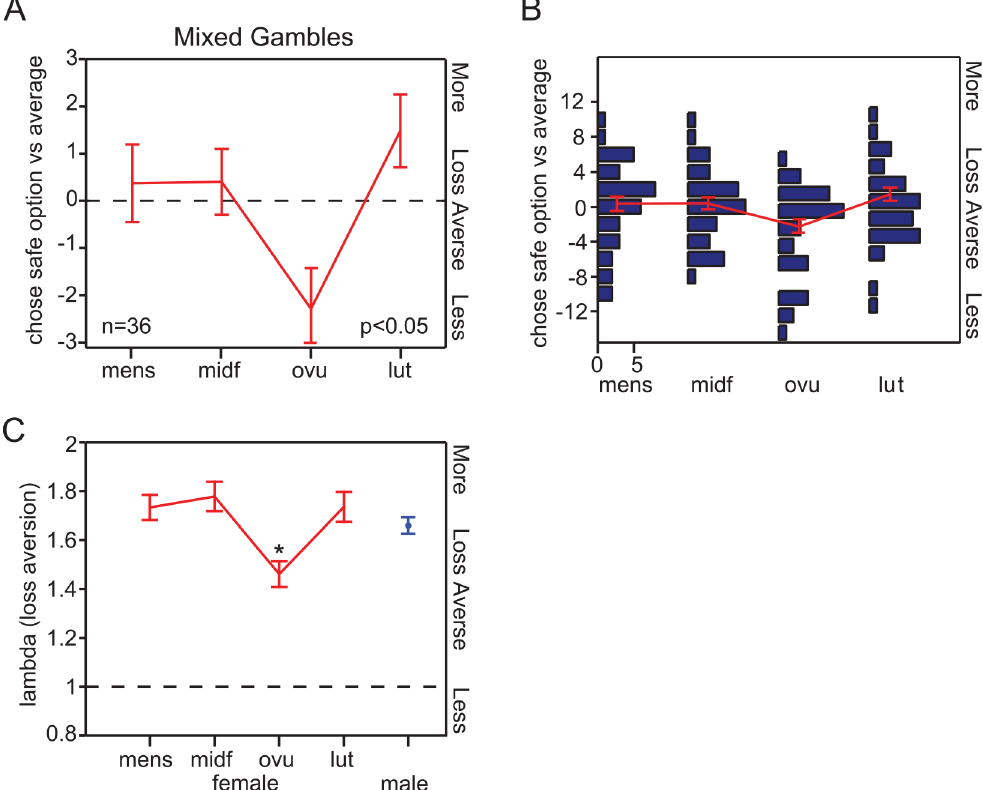
Fig 6. Results from the gambling experiment for loss aversion. (A) Effect of menstrual cycle phase on the number of times the safe certain option ($0) was chosen over the mixed gamble (ANOVA, p < 0.01). (B) Histogram of the number of safe options chosen by each individual subject, computed as the difference for each subject between the number of safe options in each cycle phase and the average number of safe options chosen across cycle phases. Fig 6A is superimposed on the histogram to display group average and s.e.m. (C) Effect of menstrual cycle phase on loss aversion. Parameter fits are estimated simultaneously for all phases with the single best noise parameter (0.94 ± 0.04) controlling for session order effects. Parameter estimates for an age-matched male population are also plotted. Subjects are less loss averse during ovulation than other phases (all p < 0.001). Loss aversion in menses, mid- follicular and luteal phases did not differ significantly from each other (all p >